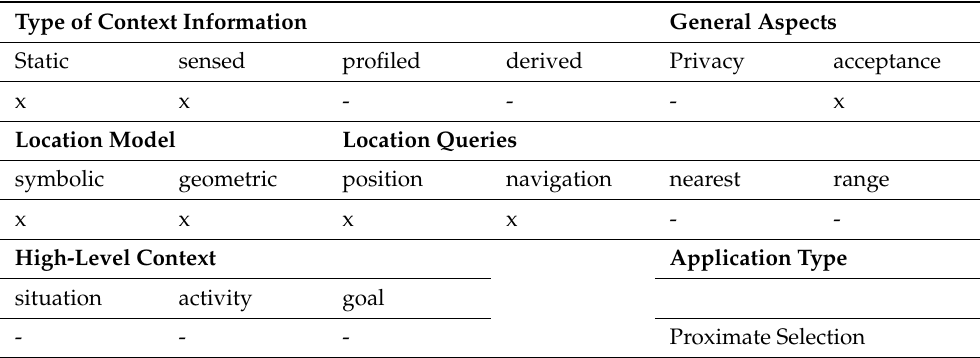
Table 1. Characteristics of the context-aware